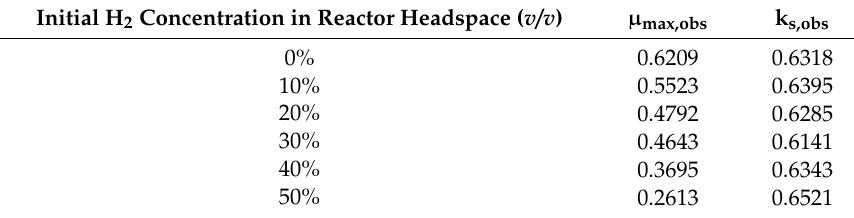
Figure 11. Determination of μ max,obs and ks, obs at different initial concentration of H 2 . Table 1. Values of observed rate constants from experiments.